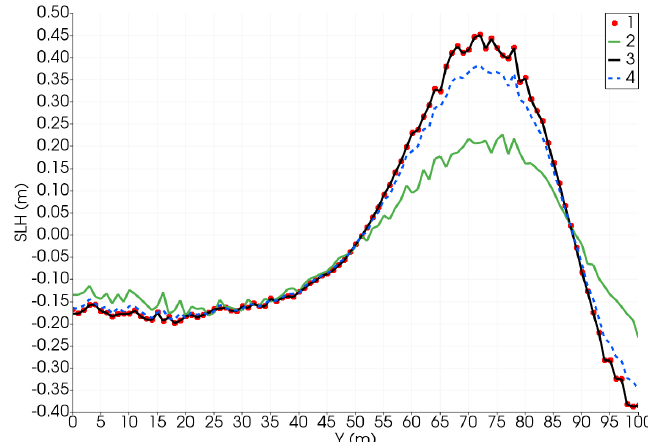
Figure 4. Sea level function on Γ op at different iterations and observational data (1—observational data; 2—the first iteration; 3—the last iteration; 4—the ninth iteration).